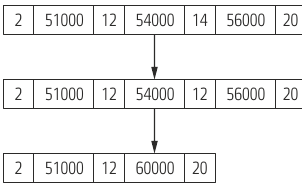
Figure 3. A mutation (node 14) followed by repair operation (remove duplicate node